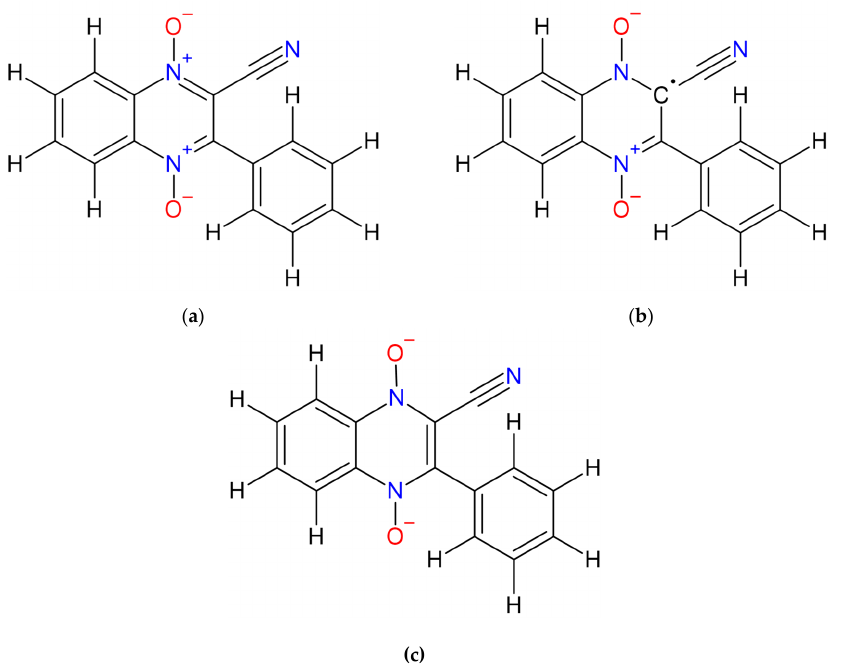
Figure 2. The structure of ( a ) the molecule, ( b ) the anion product from wave 1, and ( c ) the dianion product of wave 2 for derivative A1. Chemical structures drawn in Chemsketch Freeware [19].